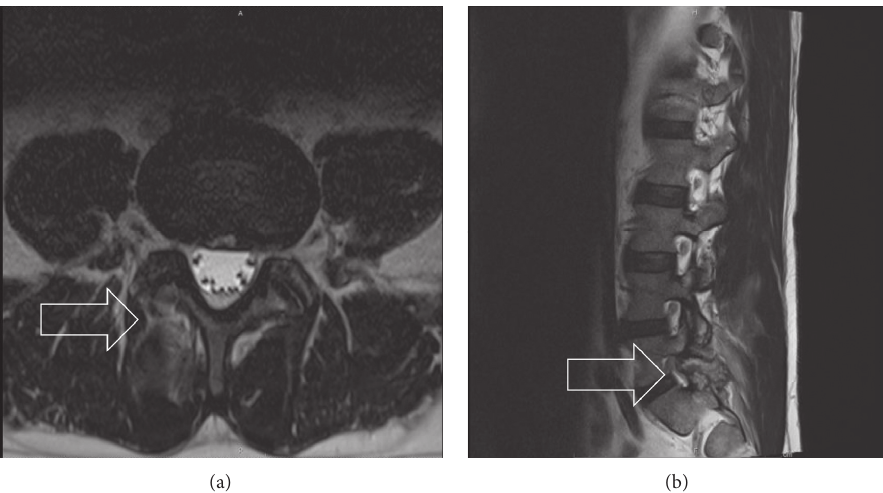
Figure 1: (a) T2 weighted axial image at L5-S1 level; (b) T2 weighted sagittal image. There is moderate diffuse circumferential disc bulging, severe right facet arthropathy, marked inflammatory changes involving the right facet joint at L5-S1, and significant edema in the posterior right paraspinous musculature near the lumbosacral junction.